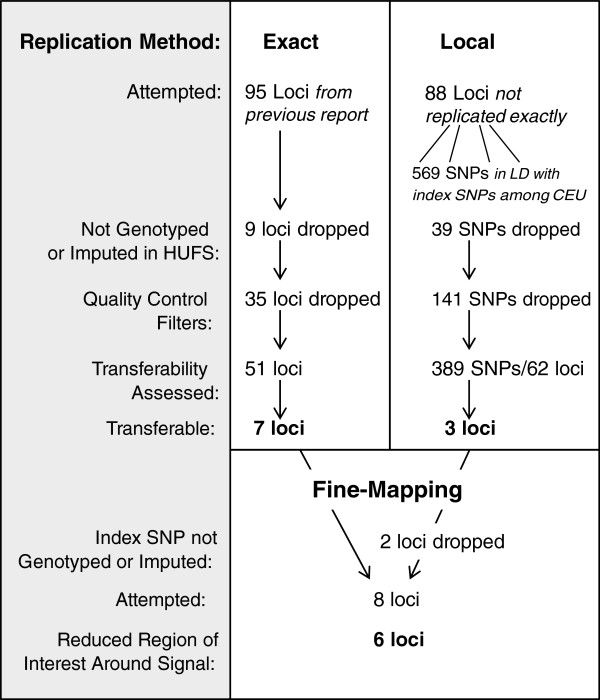
Summary of methods.